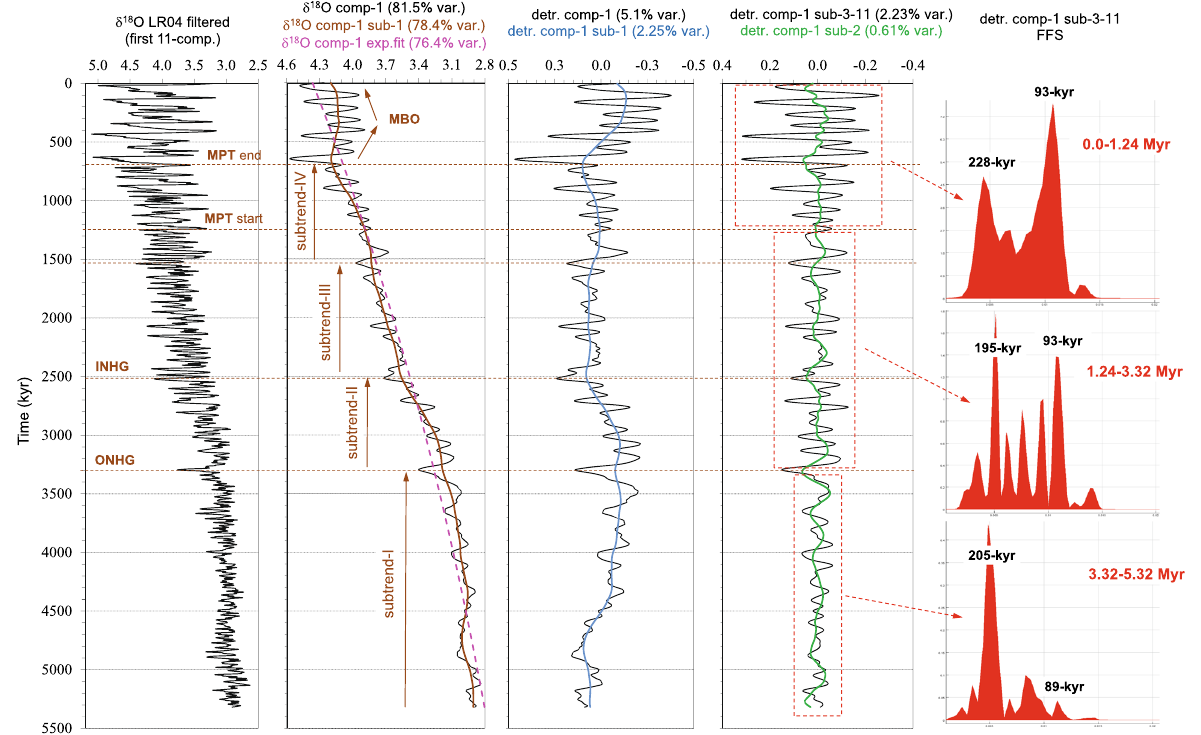
Fig. 2 Time-series panel of the δ 18 O component-1 and its subcomponents isolated by singular spectrum analysis. δ 18 O comp-1 exponential trend ( ‰ ) = 1.44194 + 2.92378 e ( − t /6963.268) . The vertical brown arrows show four subtrends of component-1 and their correlation to the NHG transitions known in the literature (MBO this study). To the right, the Fourier frequency spectrum of δ 18 O detrended comp-1 subcomp-3-11 (2.23% variance) for three time intervals are highlighted by red boxes. Note the increase in amplitude after the ONHG and MPT and the power increase of the ~93-kyr eccentricity cycle. x -axis scale variable ( ‰ ). The y -axis scale of the frequency spectrum increases upwards. Time scale in (Fig. 2, Table 2). The comp-1 subcomp-2 contains 0.8%